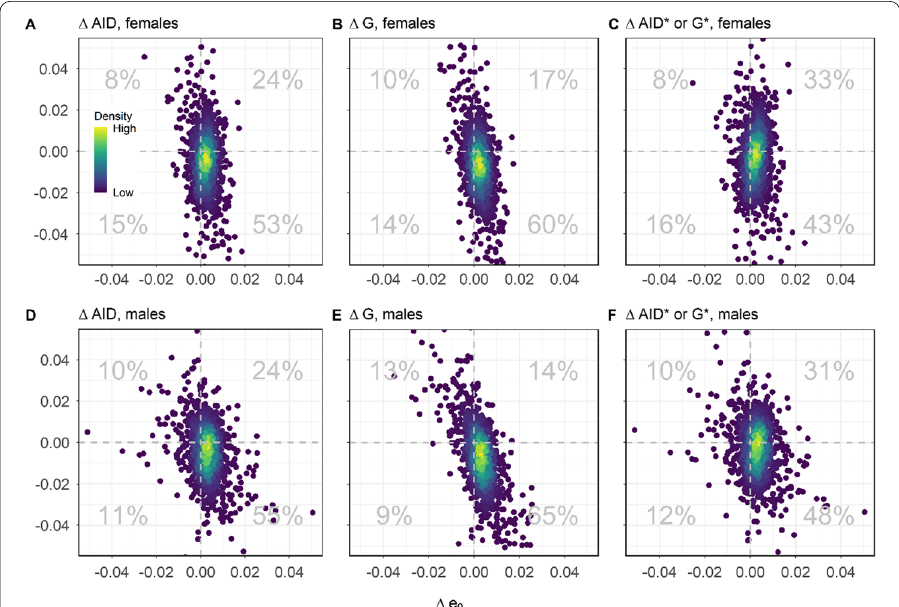
Fig. 6 Joint changes in life expectancy and lifespan variability for the average inter-individual difference ( A , D ), Gini coefficient ( B , E ), normalized Gini index ( C , F ) from 1980 onwards. The top and bottom panels show results for women and men, respectively. Percentages based on the number of occurrences in each quadrant (Source: Authors’ elaboration based on the HMD data)